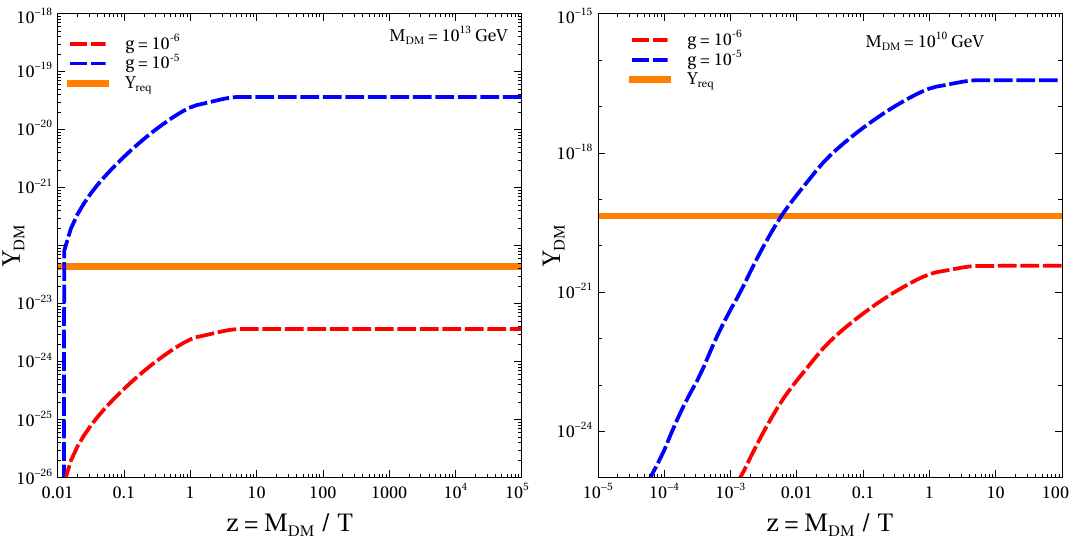
Figure 5 . Evolution of DM yield (normalised to entropy density) produced from freeze-in for M DM = 10 13 GeV (left panel) and M DM = 10 10 GeV (right panel). The red (blue) dashed lines are for g = 10 − 5 ( g = 10 − 6 ). The orange contour denotes the yield required to get the observed DM abundance. We have taken T RH = 10 15 GeV and the symmetry breaking scale v Φ = 10 13